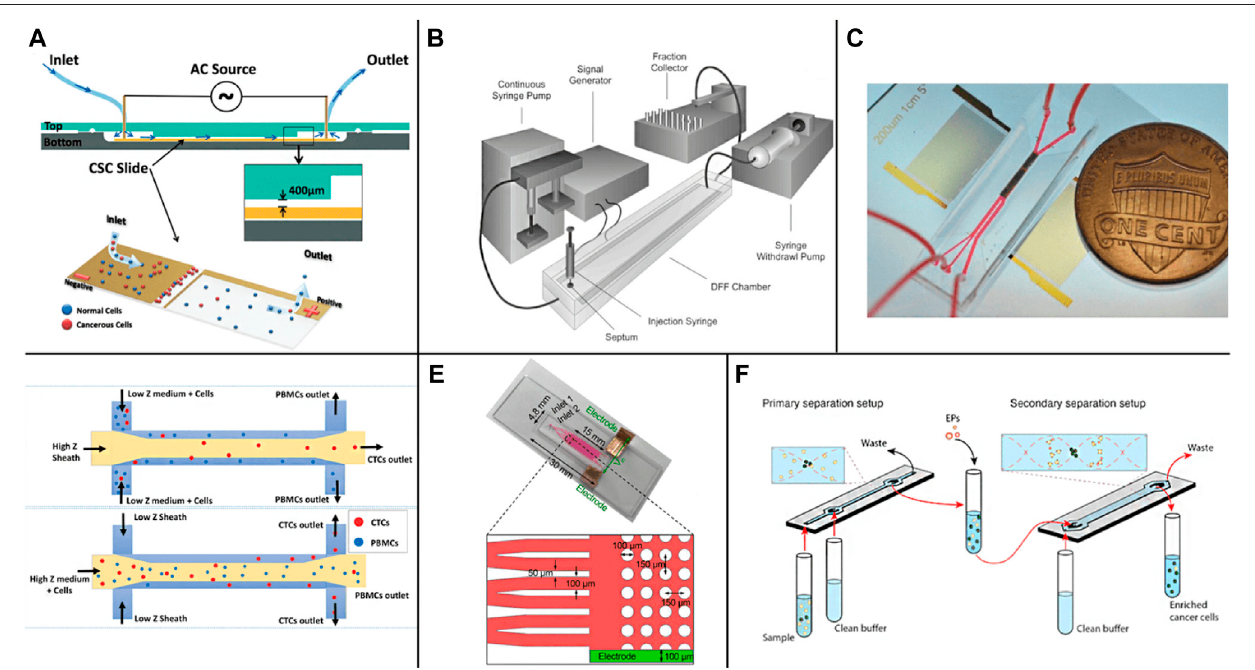
FIGURE 3 | Active enrichment methods based on physical screening (A) The CTCs detection chip based on AC electric fi eld (Jahangiri et al., 2020); (B) The DEP fl ow fractionation (depFFF) con fi guration in CTCs detection (Gascoyne et al., 2009); (C) The acoustic CTC separation device (Wu et al., 2018); (D) Size insensitive isolationofCTCsfromPBMCs(Karthicketal.,2018); (E) Themicro fl uidicdeviceonaglassslidewithanti-EpCAMmodi fi cation onthemicropost inthedevice(Sun etal., 2019); (F) The two-step acoustophoresis (Undvall Anand et al.,